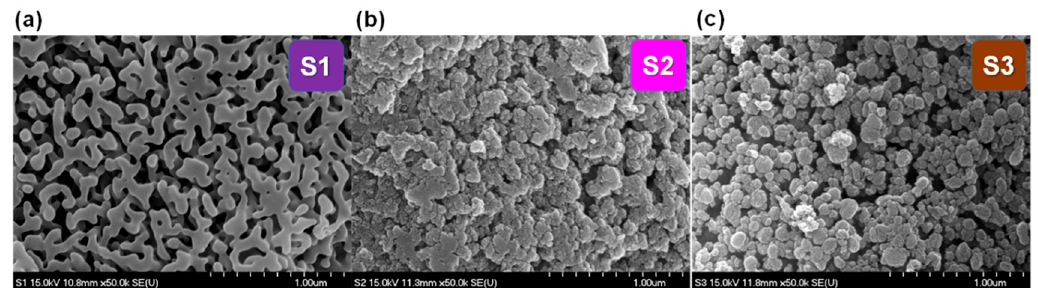
Figure 1. Images of the synthesized biogenic silica, S1, S2, and S3